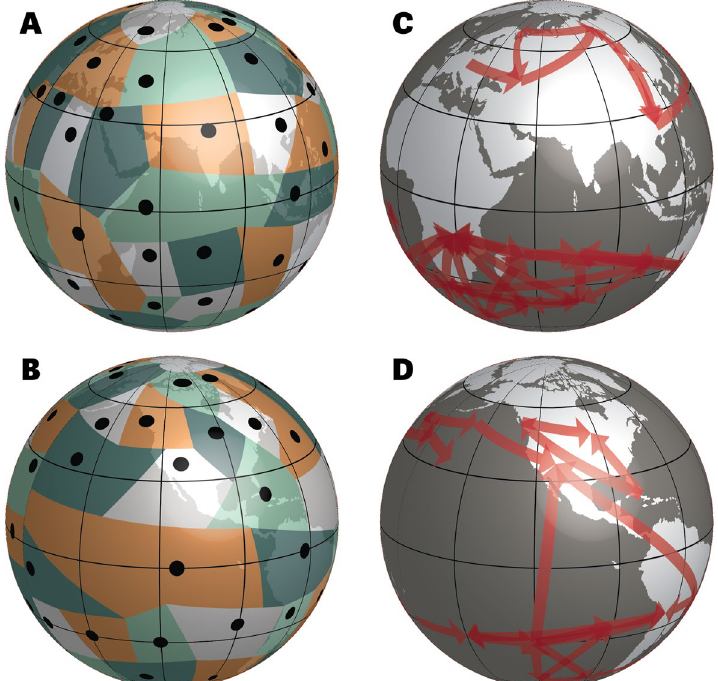
Fig. 5 Teleconnections in the Earth’s climate. The figure is adapted from Figs. 1 and 7 of Ref. Hlinka et al. (2013), and slightly simplified. Panels A and B show regions where the ground temperatures are highly correlated. The dots marking the most representative grid point. Panels C and D show Granger causality links between these regions. I.e., an arrow from region i to j means that the temperatures at i are correlated to those at j if they are shifted forward in time. We omit regions without